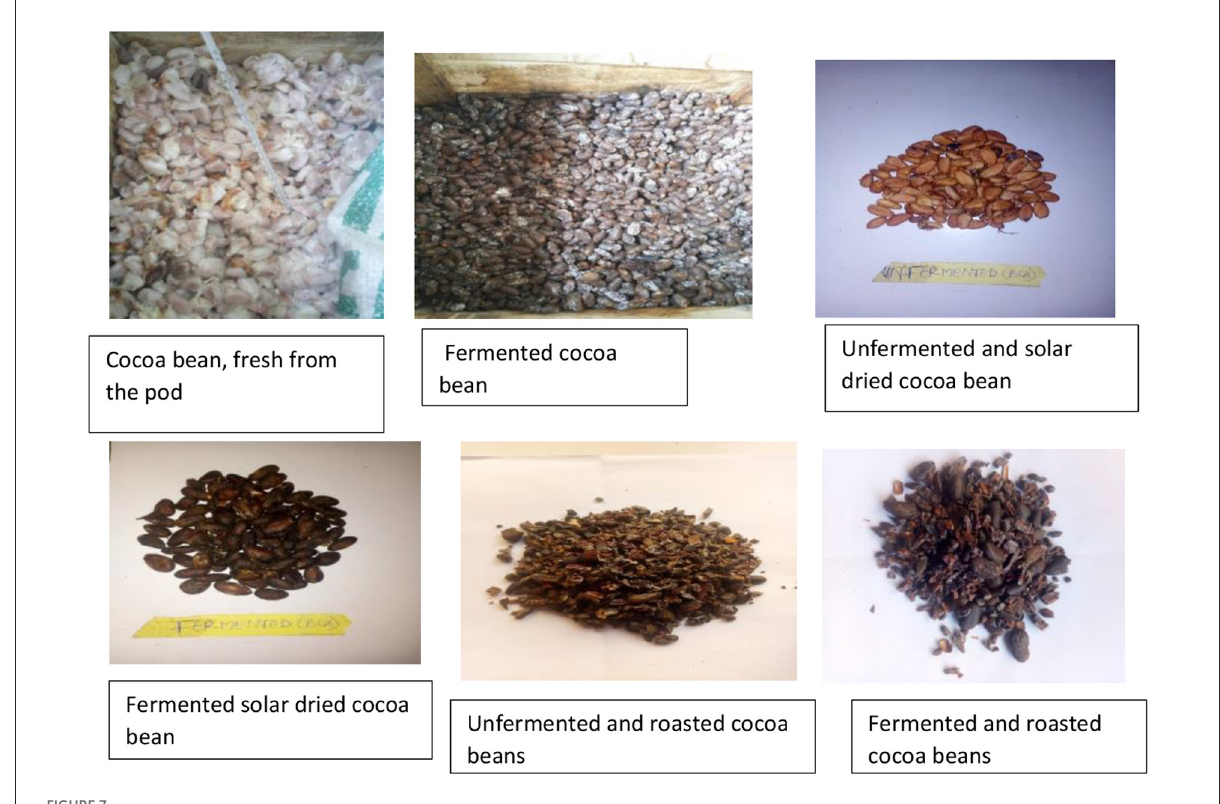
FIGURE7 Products from different stages of cocoa bean processing.